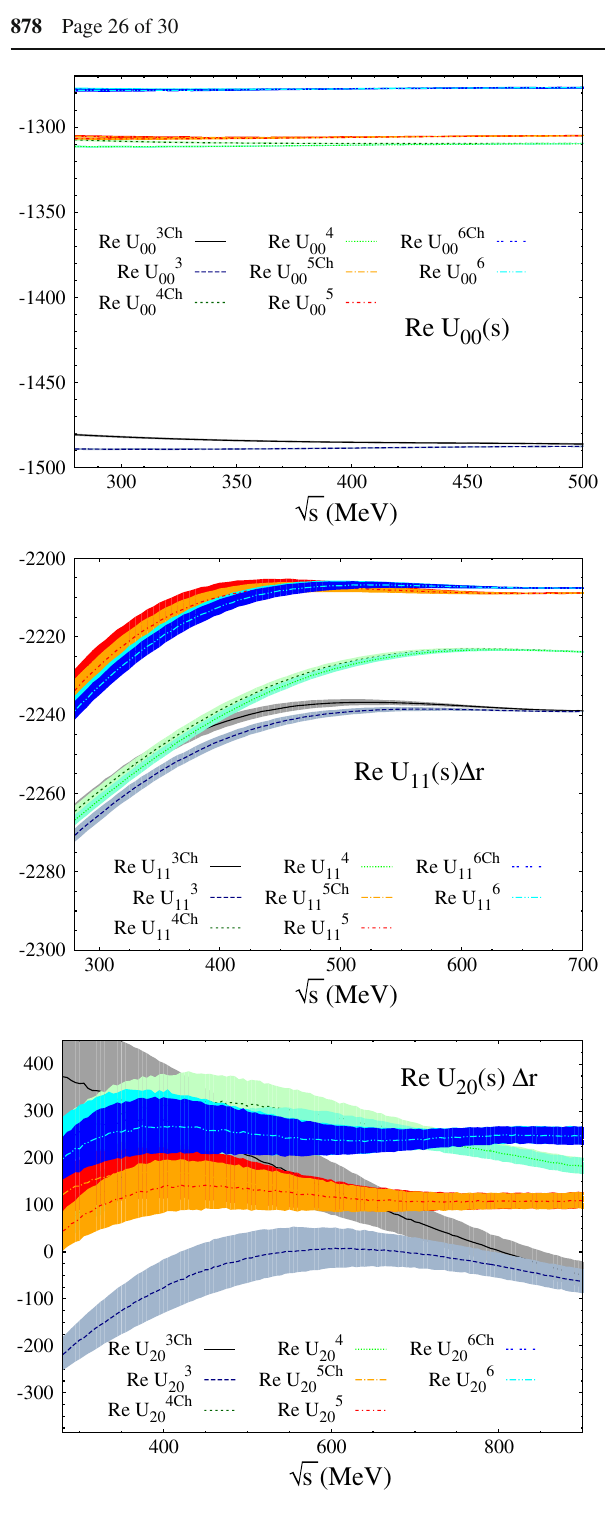
Fig. 13 Real part of the inner delta-shell potential for the S0, P and S2 partialwaveswhenthechiraltailisincludedorexcluded.Theonlydiffer at low energies. Gray (light-gray), green (light-green), red (orange) and blue (cyan) bands correspond to the results with (without) the chiral tail for r c = 0 . 9, 1 . 2, 1 . 5 and 1 . 8 fm,